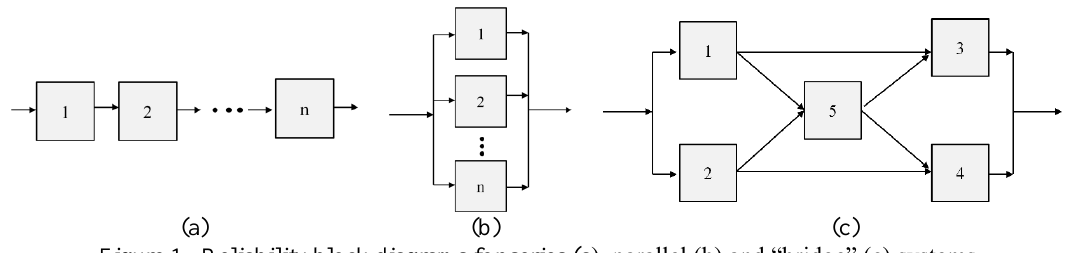
Figure 1. Reliability block diagrams for series (a), parallel (b) and “bridge” (c)